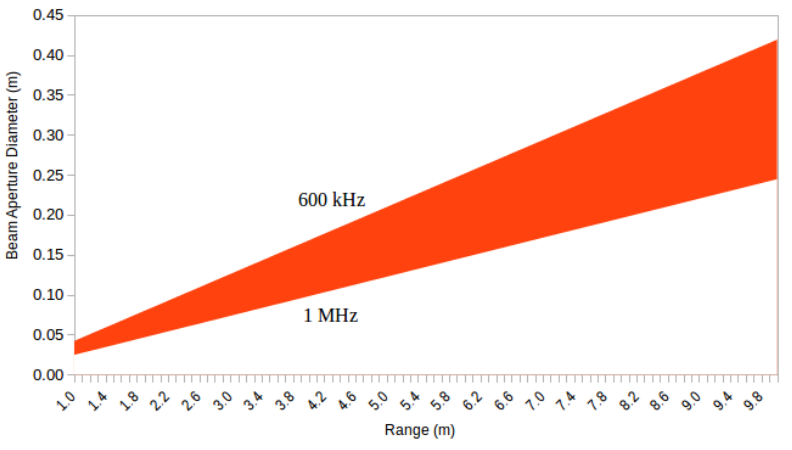
Figure 15. The behavior of projected distances on a surface as the range and frequency